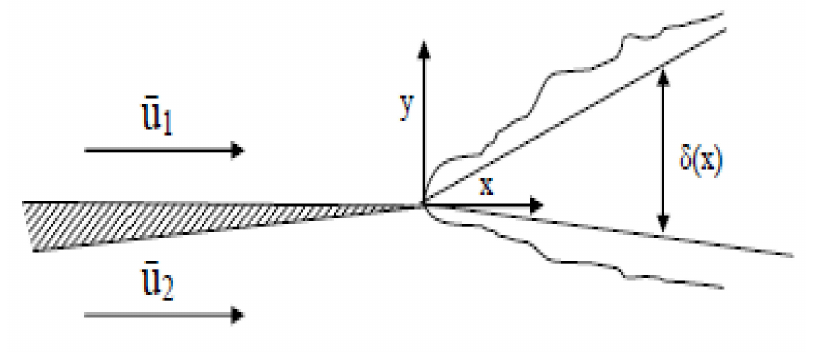
Figure 9. Turbulent mixing